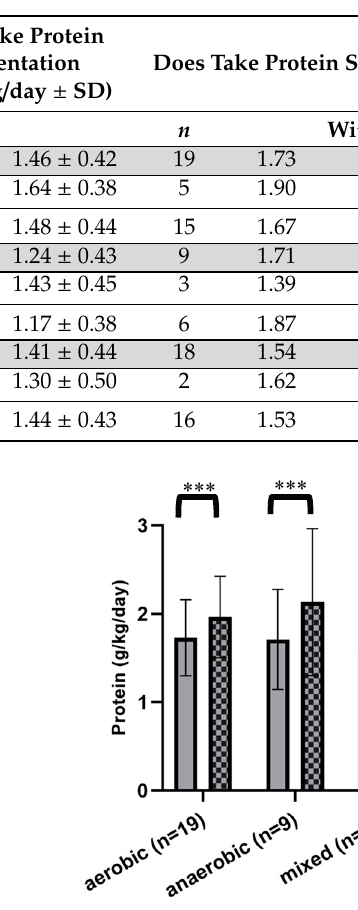
Table 3. Mean of protein daily intake dividing the cohort among athletes who supplement with protein and athletes who do not.